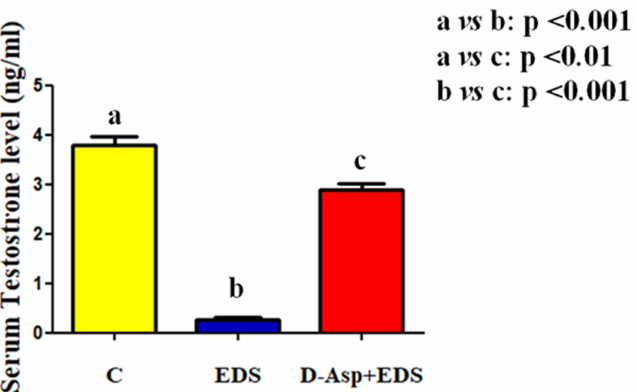
Figure 1. Serum testosterone (ng/mL) level from control, ethane dimethane sulfonate (EDS), and D-Aspartic acid (D-Asp) + EDS treated rats. In the EDS-treated rats, testosterone concentration strongly decreased, while in D-Asp + EDS treated animals, the decrease is less pronounced. Values are expressed as mean ± SEM from 5 animals in each group.